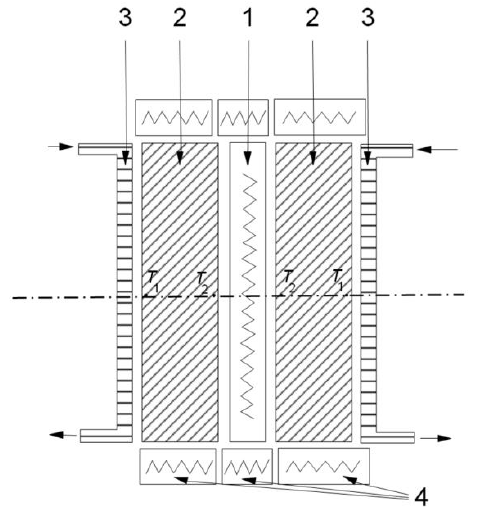
Figure 2. Sketch of the guarded hot ring system with two equal